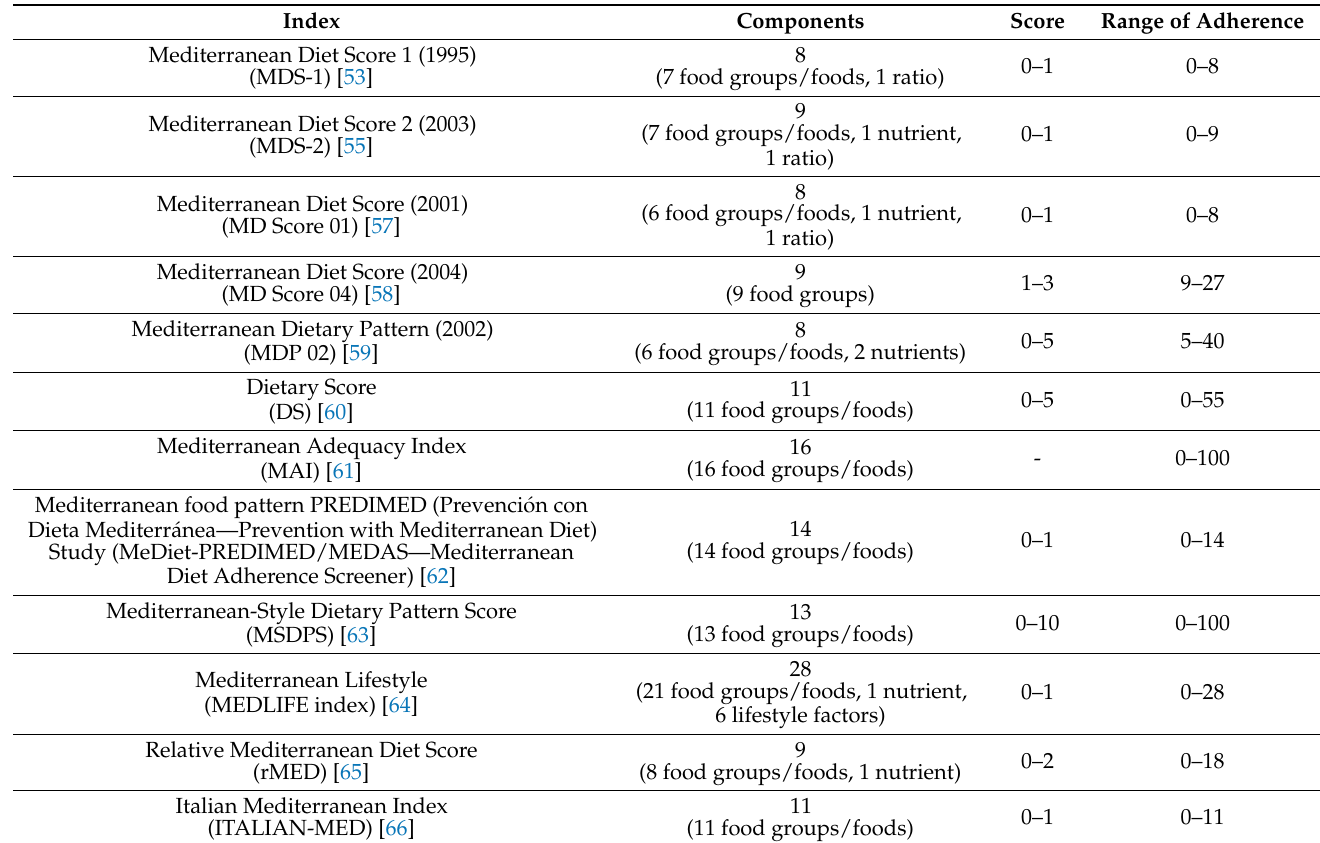
Table 1. Main characteristics of some of the indexes used to estimate the adherence to the Mediterranean diet (MeD). For a deeper review, see